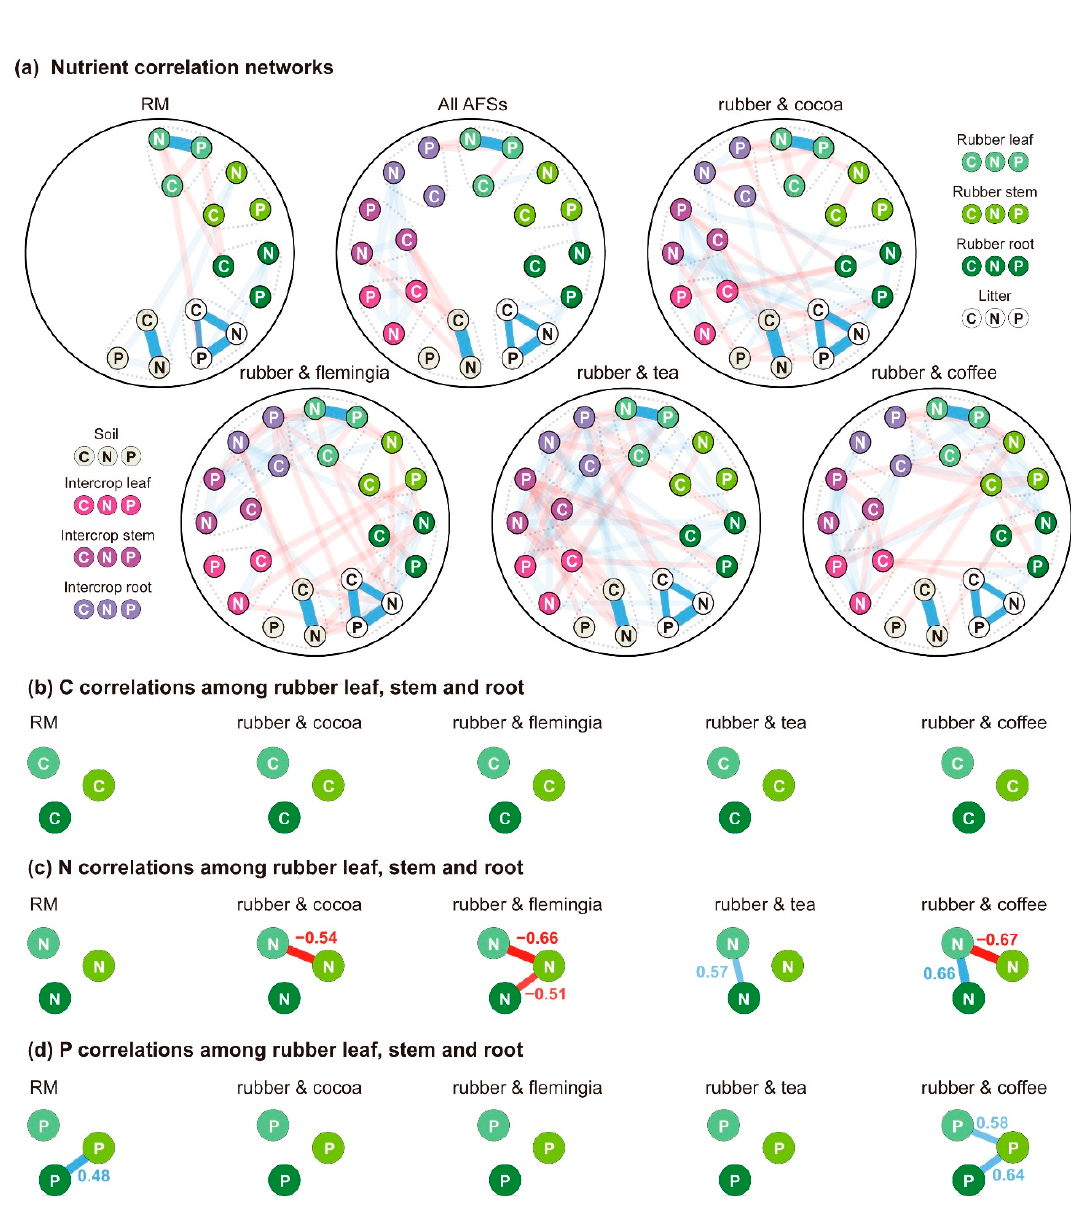
Figure 4. ( a ) The nutrient correlation networks ( r ≥ 0.5; p < 0.05) in the rubber monoculture (RM), rubber and cocoa, rubber and flemingia, rubber and tea, and rubber and coffee AFSs; ( b ) the C correlations, ( c ) N correlations, and ( d ) P correlations among the rubber leaves, stems, and roots from each site. The blue and red connecting lines indicate positive and negative correlations, respectively. Their width indicates the strength of the correlation. The connecting correlation lines that were not discussed specifically are indicated by the faint colors.